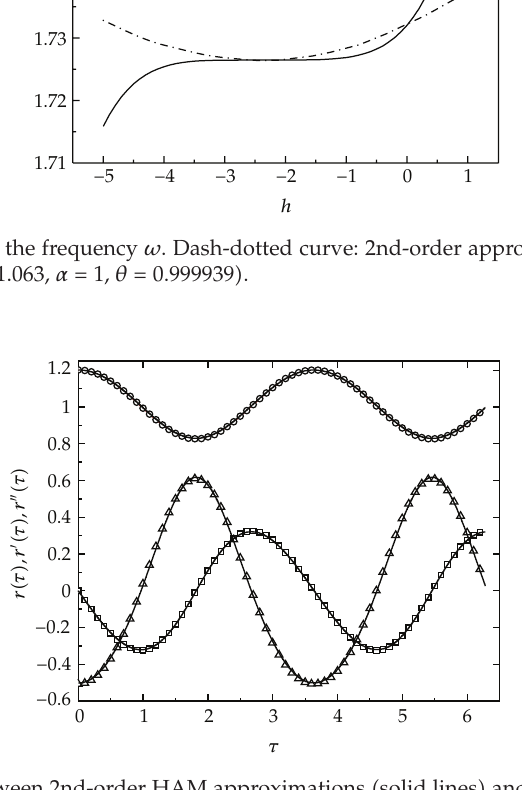
Figure 2: Comparison between 2nd-order HAM approximations (cid:3) solid lines (cid:4) and Runge-Kutta numerical solutions (cid:3) open symbols (cid:4) for: r (cid:3) τ (cid:4) (cid:3) circles (cid:4) , r (cid:6) (cid:3) τ (cid:4) (cid:3) squares (cid:4) , and r (cid:6)(cid:6) (cid:3) τ (cid:4) (cid:3) triangles (cid:4) ; ξ (cid:9) 1 . 063, α (cid:9) 1, θ (cid:9) 0 . 999939, h (cid:9) − 2 .